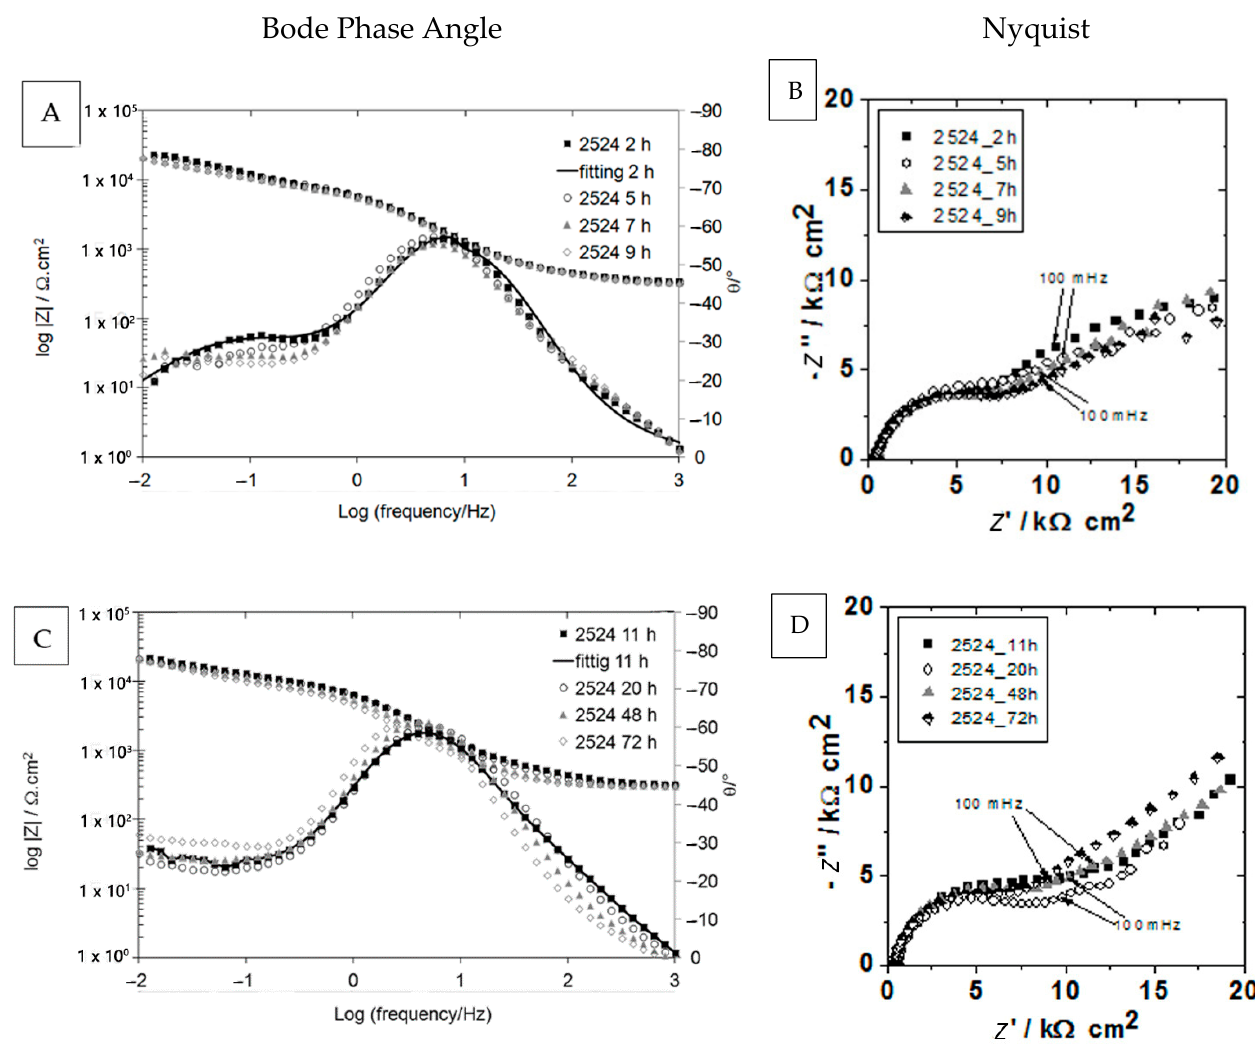
Figure 6. Evolution of EIS results for the AA2524-T3 as a function time of exposure to 0.01 mol L − 1 NaCl electrolyte. ( A ) Bode phase angle and ( B ) Nyquist diagram. Measurements taken after 2, 5, 7, and 9 h of the experiment. ( C ) Bode phase angle and ( D ) Nyquist diagram. Measurements taken after 11, 20, 48, and 72 h of the experiment.